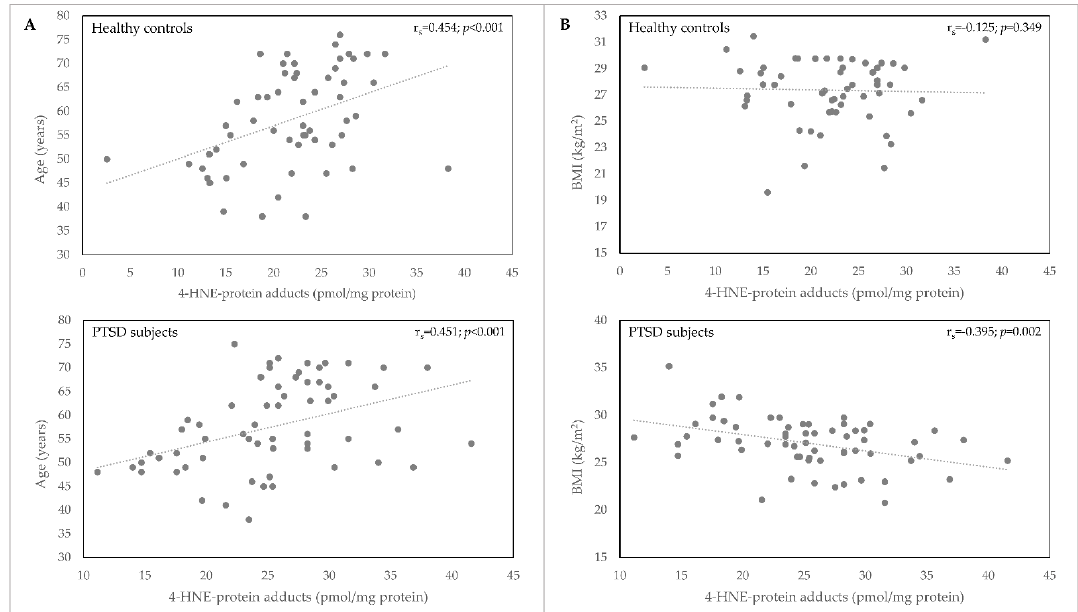
Figure 2. Correlation of 4-HNE–protein adducts plasma concentration (pmol/mg protein) with age ( A ) and BMI ( B ) in samples of healthy controls ( n = 58) and PTSD subjects ( n = 62). BMI, body mass index; 4-HNE, 4-hydroxynonenal; PTSD, posttraumatic stress disorder.